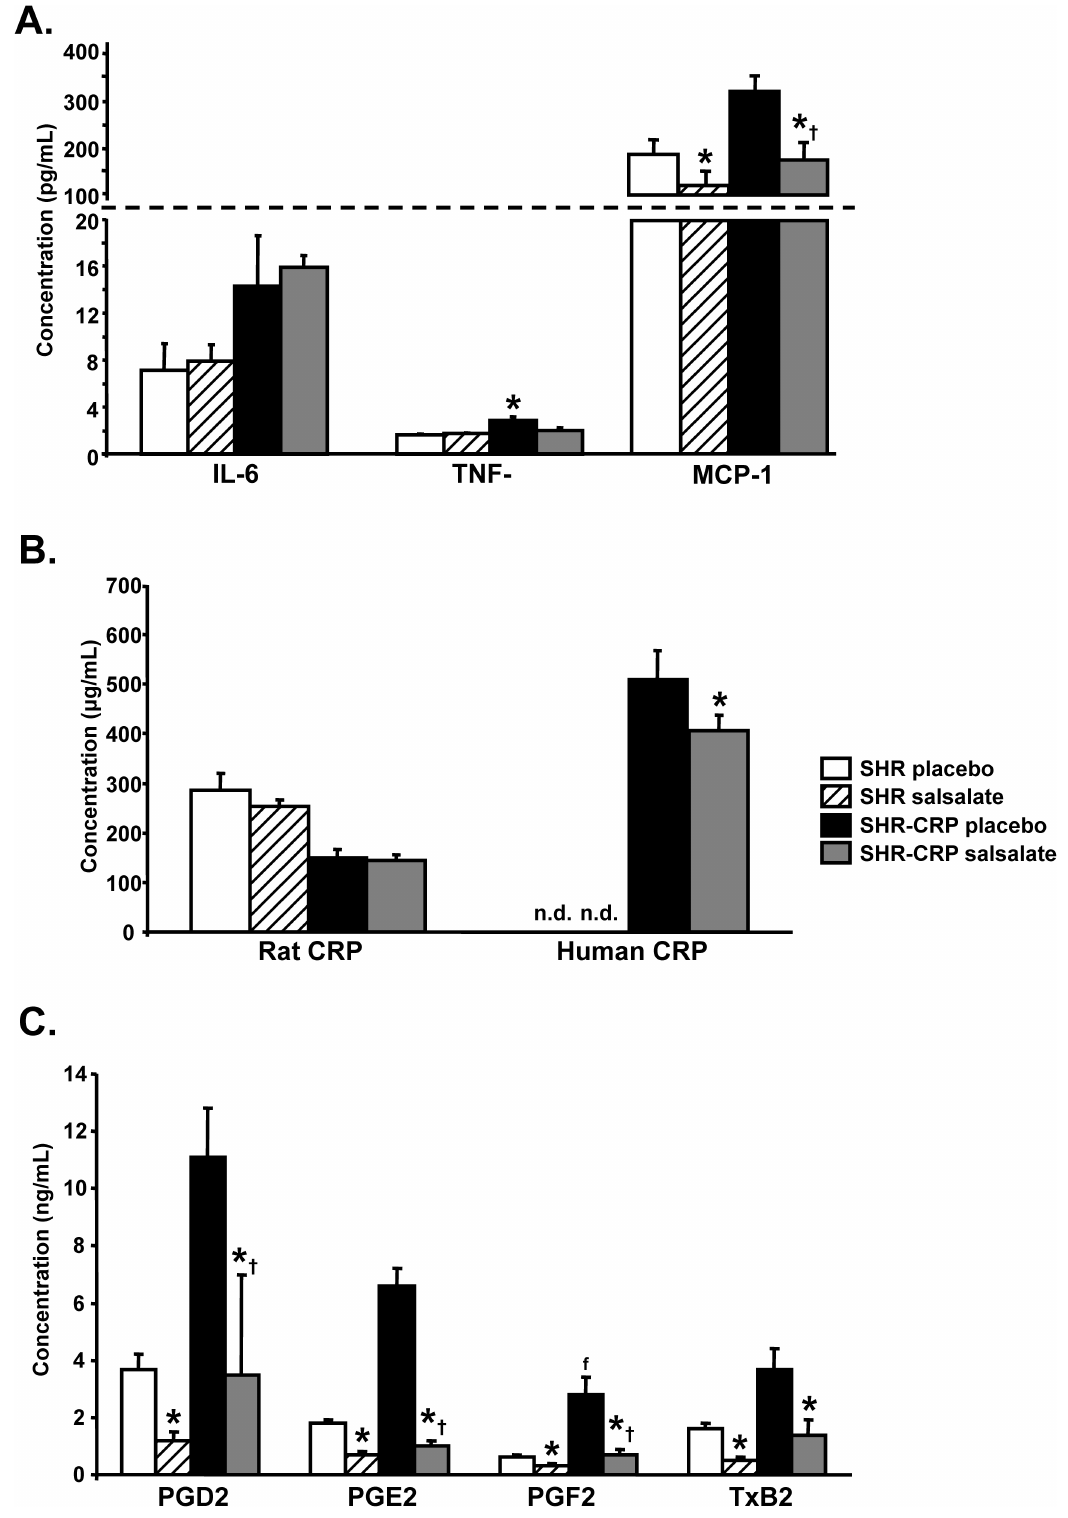
Fig 1. Inflammatory markersin serum from SHR and SHR-CRP transgenic rats treated with placebo or with salsalate. A. Concentrations of IL-6, TNF- α and MCP-1 markers. SHR-CRP rats showedsignificantly increased concentrations of IL-6 when comparedto SHR rats, but there were no differences betweenrats treated with placeboor